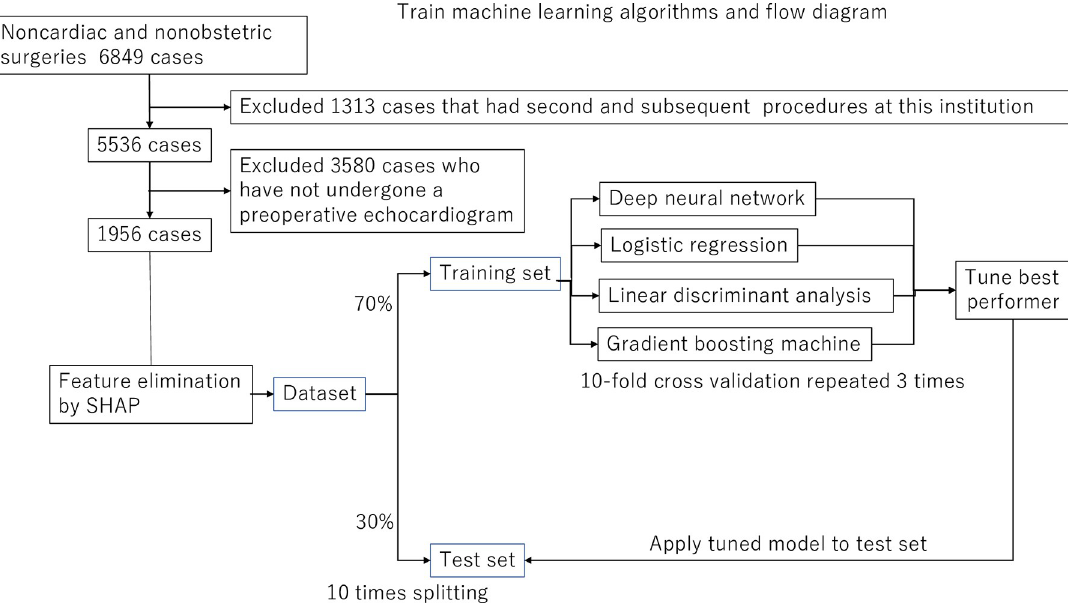
Fig 1. Diagram of methods. The complete data set was split into training and test sets ten times. The machine learning methods were trained, and the best performer was selected for additional parameter tuning before being applied to the test set for validation.